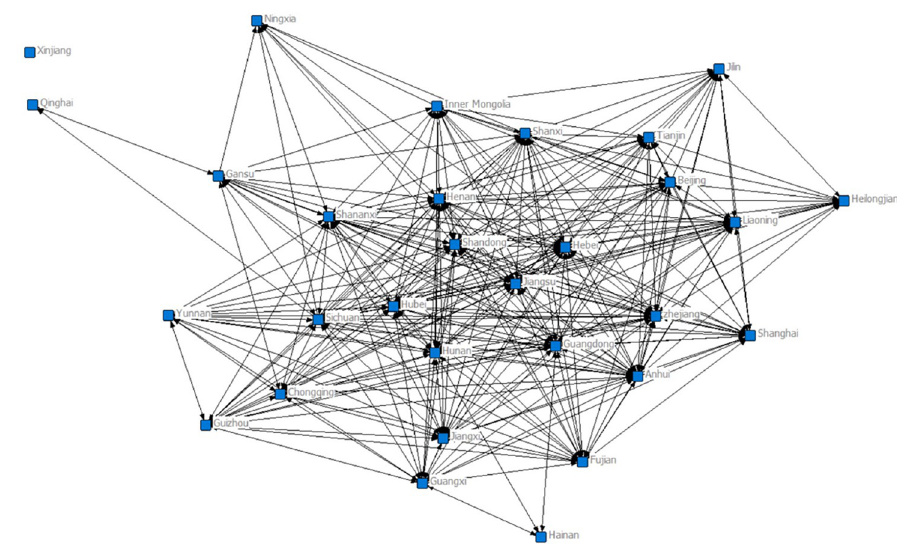
Fig 9. Topology of the 30-city converged network in